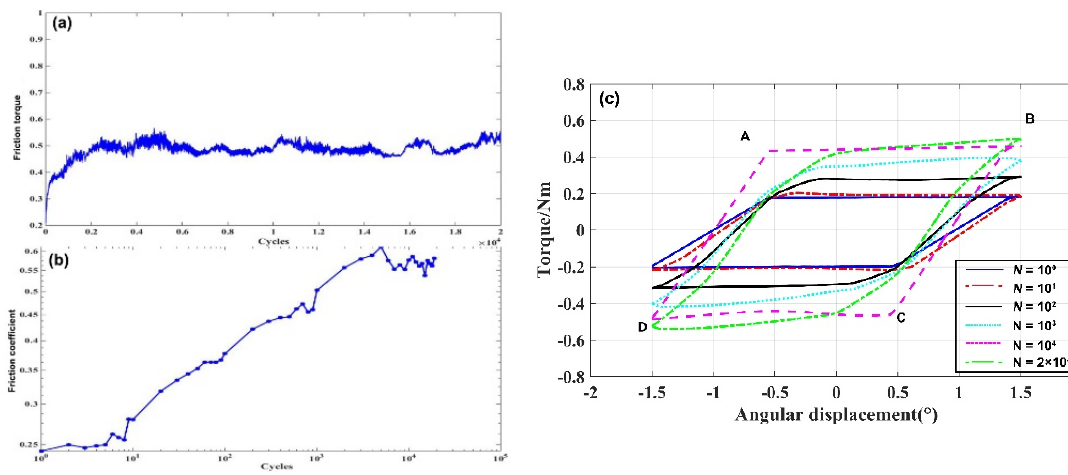
Figure 6. Relationship between the ( a ) friction torques and ( b ) friction coefficient of AM-Inconel 625 and the number of cycles at room temperature; ( c ) typical friction torque versus angular displacement amplitude curves ( T- θ curves) at the fretting cycles of 10 0 , 10 1 , 10 2 , 10 3 , 10 4 and 2 × 10 4.